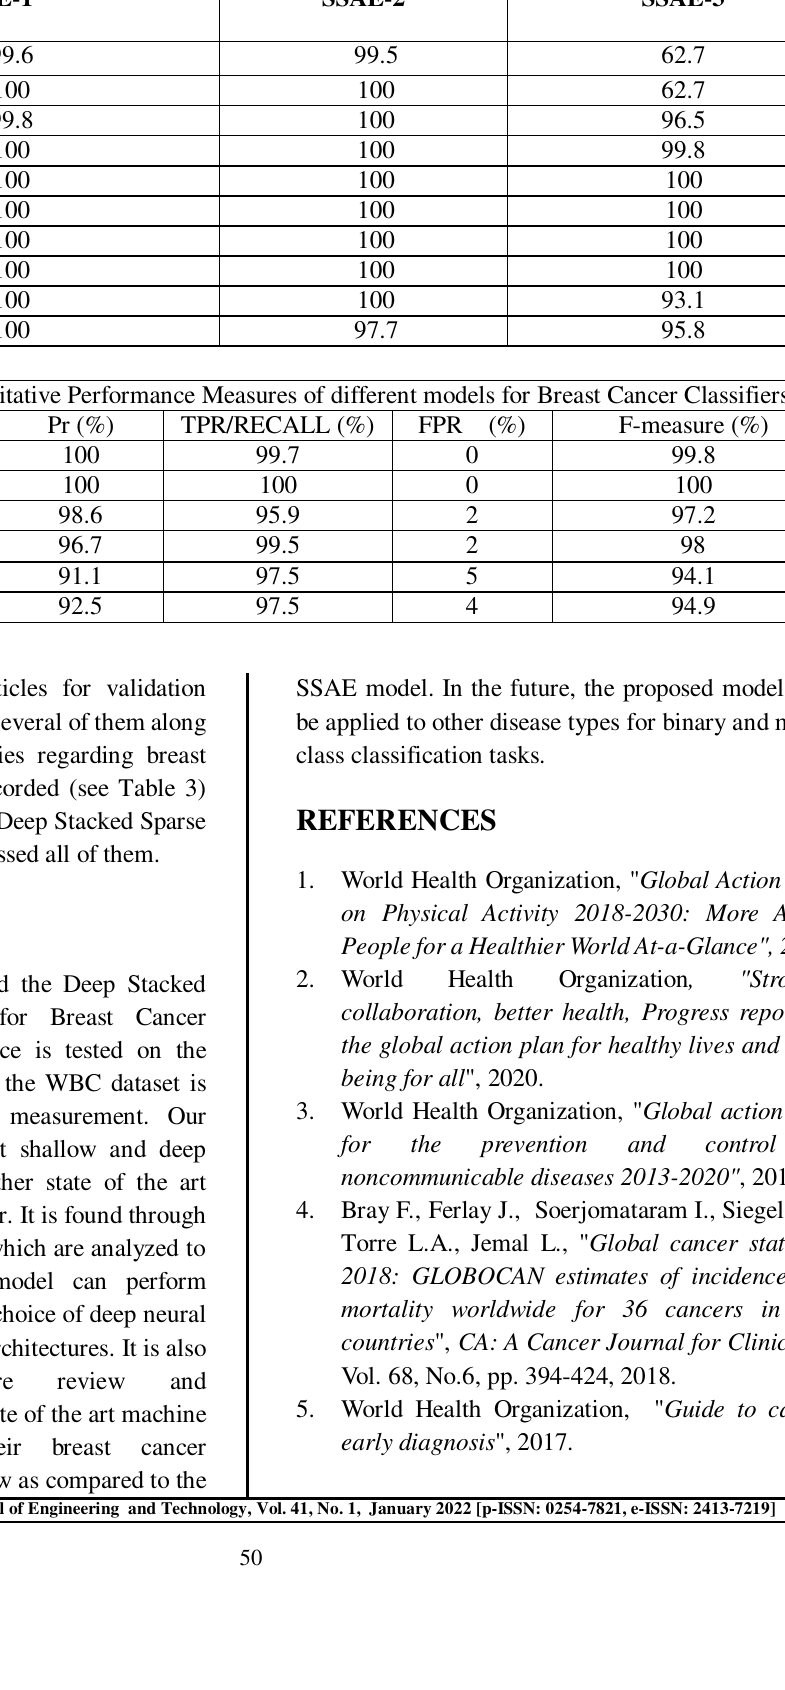
Table 4: Comparative Classification Accuracies of 3-Sparse Autoencoders with variable Hidden Layer Sizes # Hidden